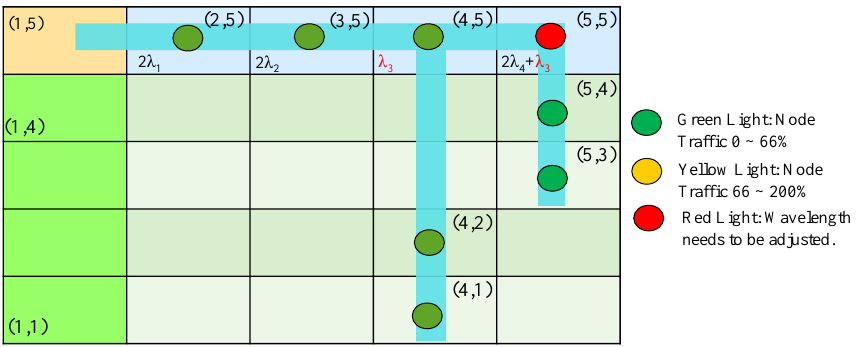
ffi c changed of two-plane optical tunnel switching network with 25 Figure 19. Traffic changed of two-plane optical tunnel switching network with 25 nodes. Figure 19. Tra